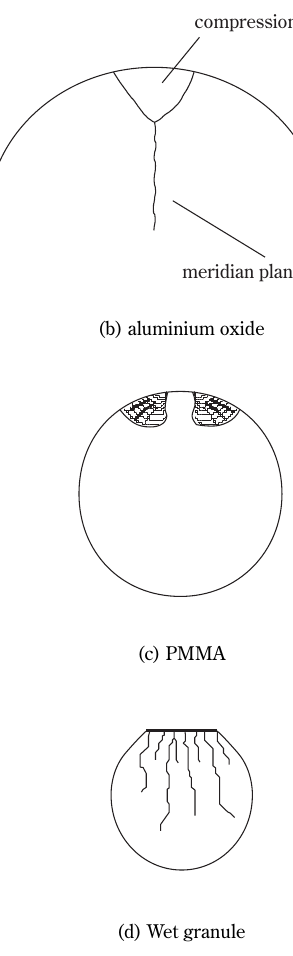
Fig. 2 Normal low impact velocity regime failure patterns of sev- eral